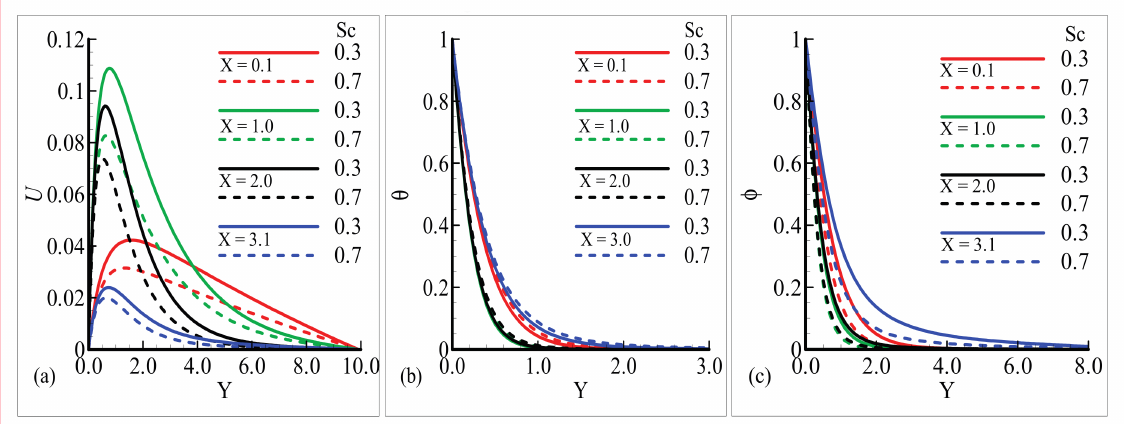
Figure 2. Physical e ff ects on quantities ( a ) U , ( b ) θ , and ( c ) ϕ versus Sc when Nt = 0.02, Nb = 0.2, Pr = 0.72, M = 0.2, Q = 1.0.